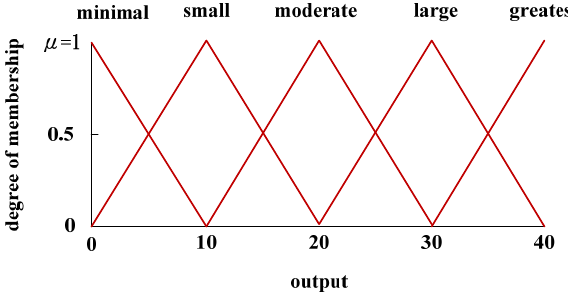
Figure 5. Degree of membership of output variable.